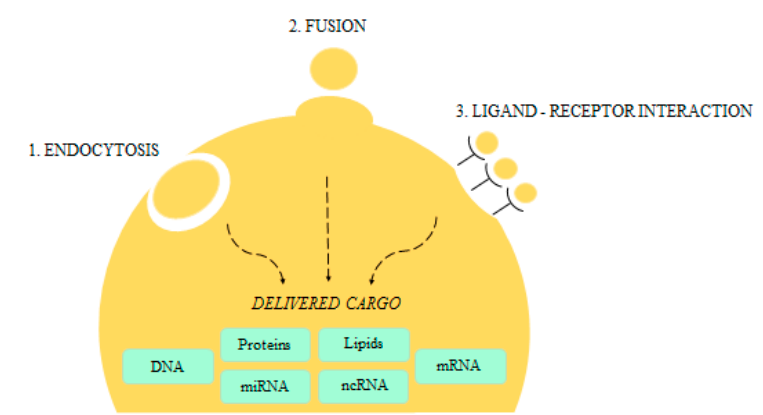
Figure 2. EVs mechanisms of intercellular communication without direct cell-to-cell contact.